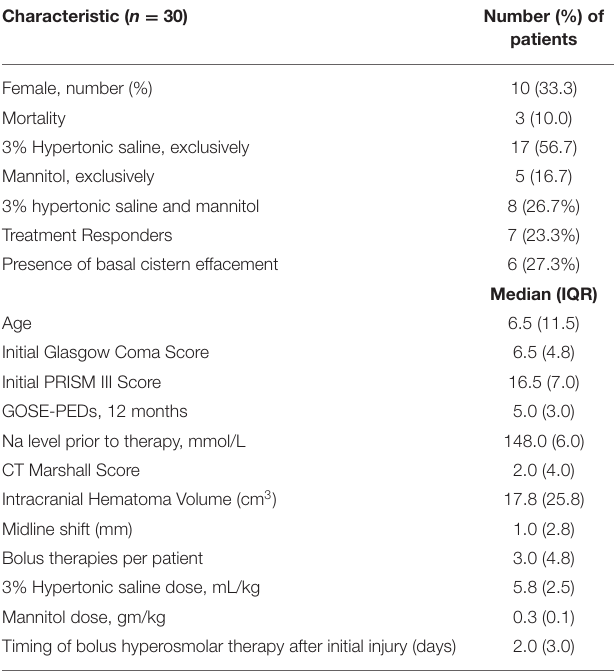
TABLE 1 | Patient